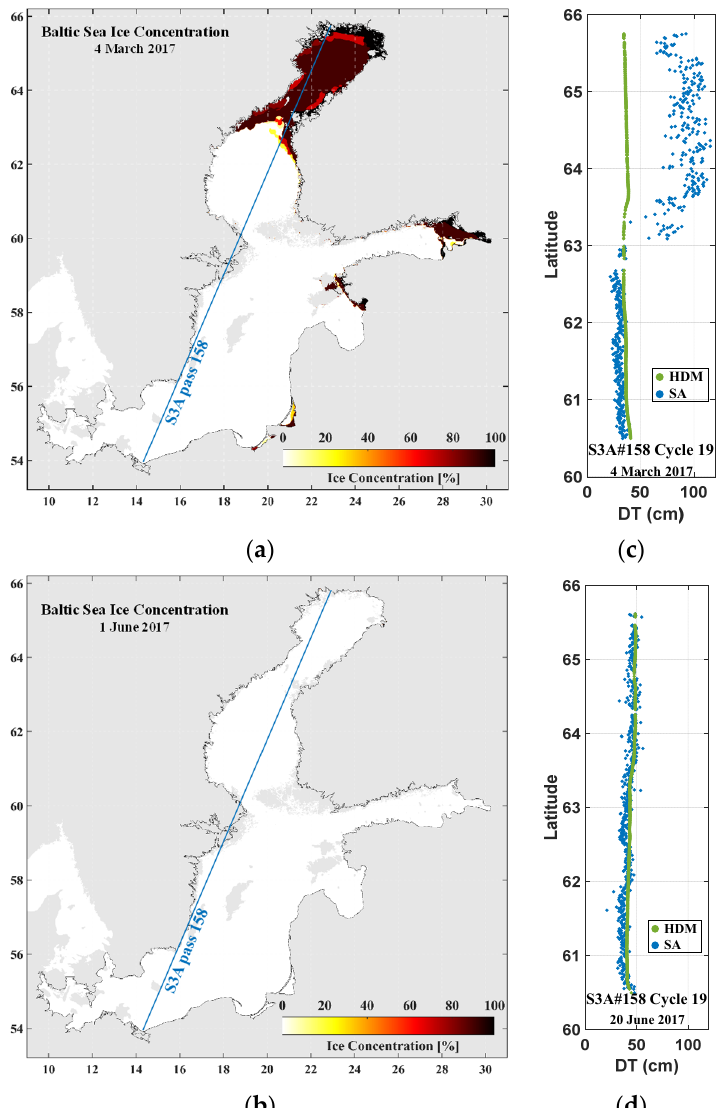
Figure 13. Sea ice concentration over Baltic Sea for March ( a ) and June ( b ) 2017 (source: gridded ice chart model available from Copernicus Marine Service Information) and the comparison between DT HDM − corr (green) and DT SA (blue) over pass#158 in two cycles, cycle 15, March ( c ) and cycle 19, June ( d ) 2017.